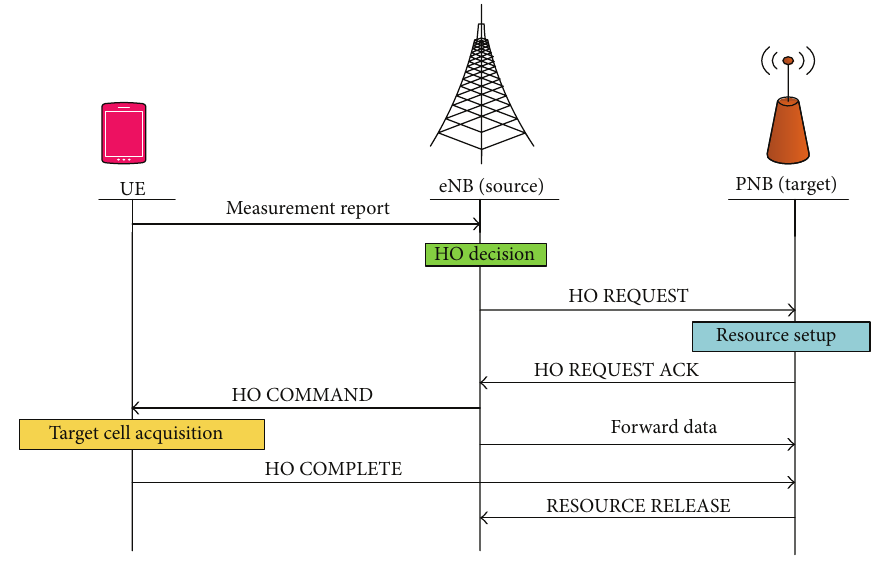
Figure 4: X-2-based handover procedure